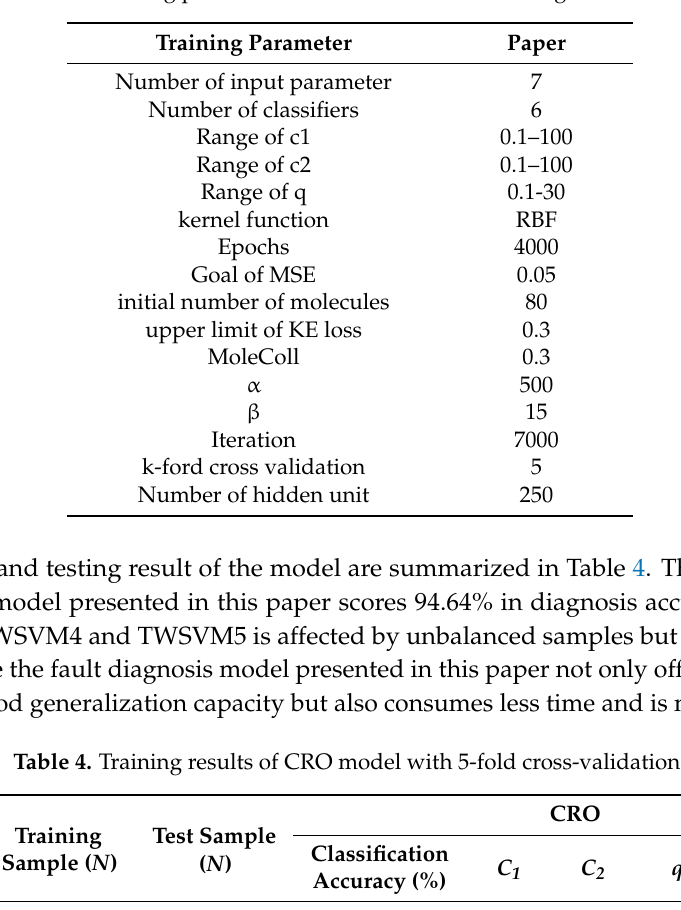
Table 3. Training parameters of CRO-TWSVM fault diagnosis model.